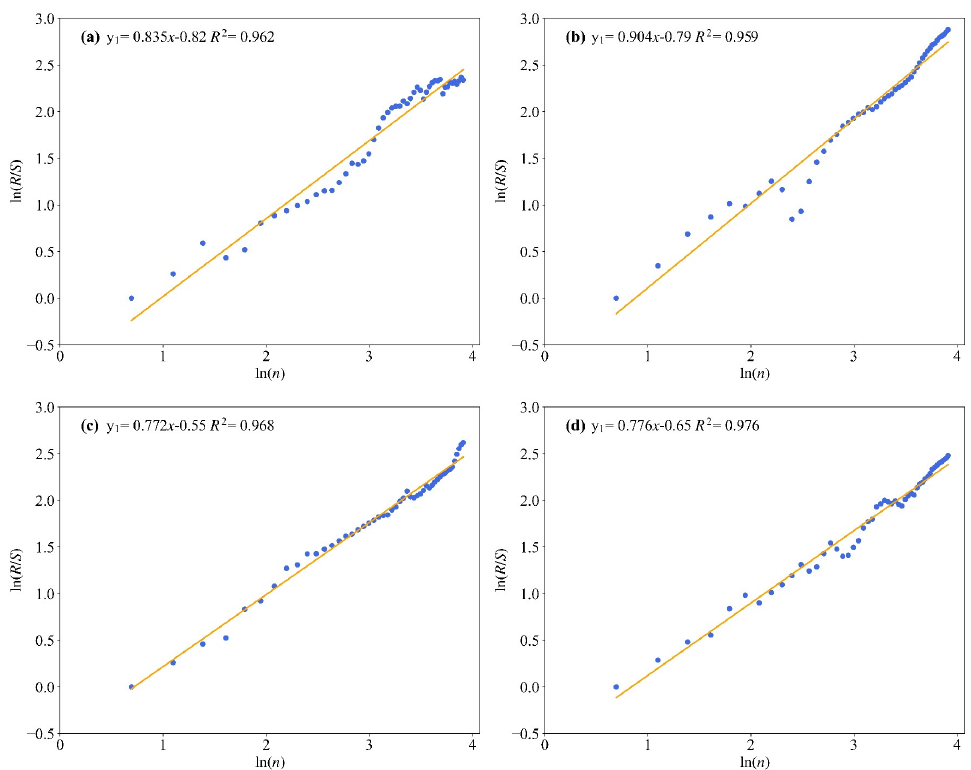
Figure 2. Variations of SD in ( a ) Spring, ( b ) Summer, ( c ) Autumn and ( d ) Winter.